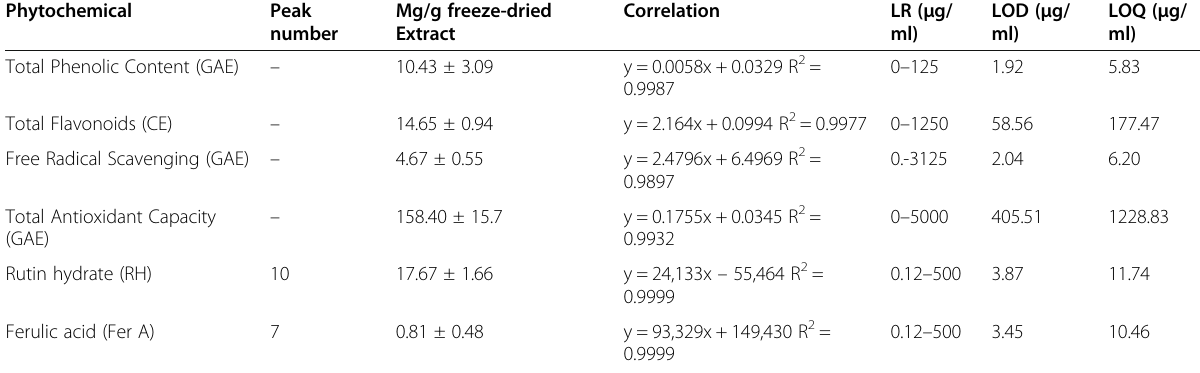
Table 2 Calibration curves, linear range, and detection and quantification limits of CCAE phytochemical analysis Phytochemical Peak Mg/g freeze-dried number